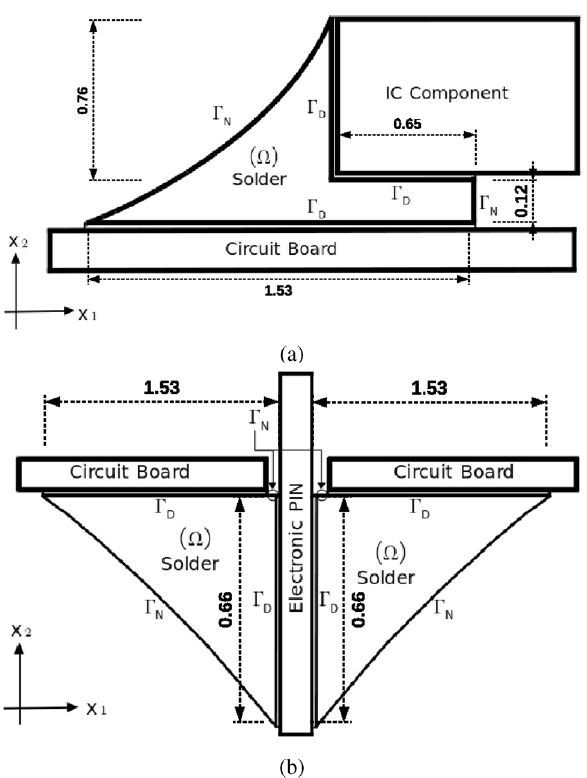
Fig. 13 Computational domain of the solder problem: a Fillet shape [54] and b volcano shape